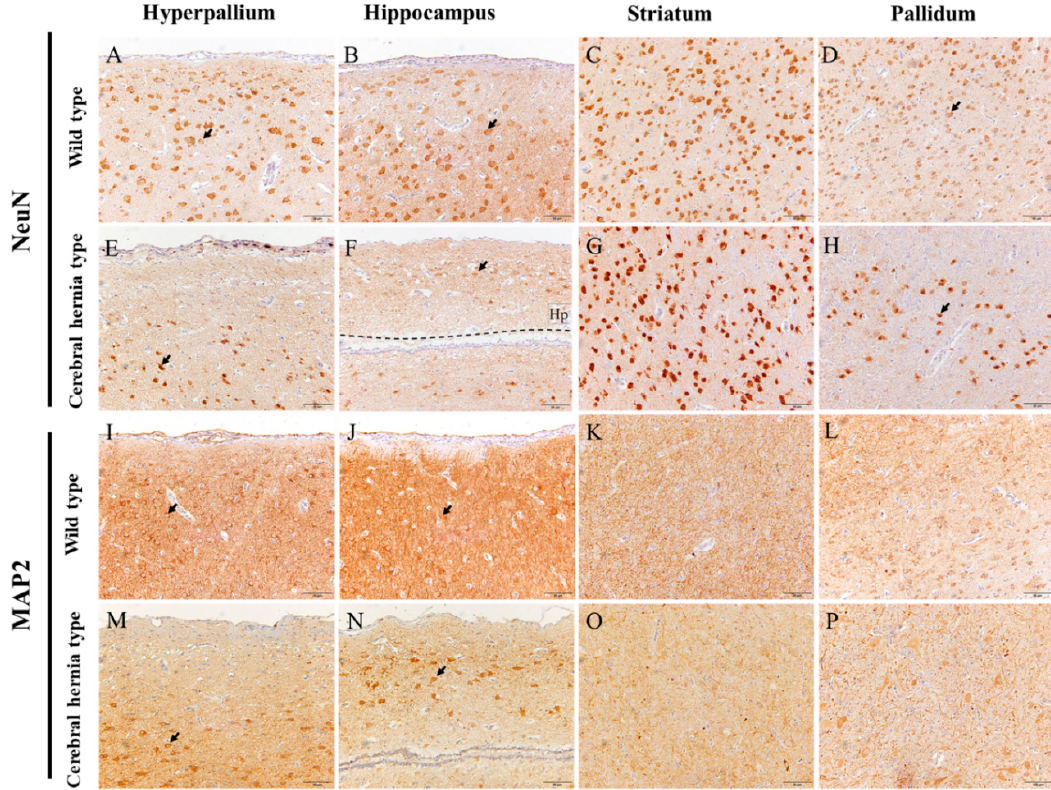
Figure 5. Abnormal neurons and dendrites are identified with NeuN and MAP2 antibodies by using immunohistochemistry in the telencephalon of chickens with and without cerebral hernia. ( A – H ) The positive signals of NeuN are detected in the neurons of H, Hp, St, and P regions of the telencephalon of wild type ( A – D ) and cerebral hernia type ( E – H ) chickens, respectively. In the telencephalon of chickens with cerebral hernia, the number of neurons is sparse with shrinking of the neuron body and nucleus pyknosis in H and Hp regions ( E , F ). The neurons in the St and P regions had intensely stained signals ( G , H ). The Hp region in cerebral hernia is located above the black dotted line in image F. ( I – P ) The positive signals of MAP2 are identified in the H, Hp, St, and P regions of the telencephalon of wild type ( I – L ) and cerebral hernia ( M – P ) chickens, respectively. The dendrites are well developed in wild type chickens, while in cerebral hernia chickens, the dendrites are atrophied in the H, Hp, St, and P regions. The neurons and blood vessels are indicated with black and yellow arrows, respectively. Scale bars = 50 µ m (all